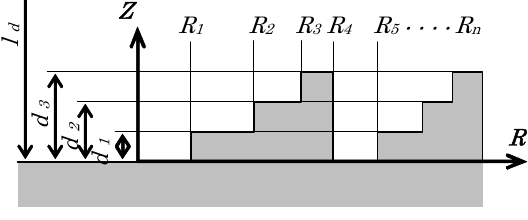
Fig.2 Fresnel Lens Cross Section